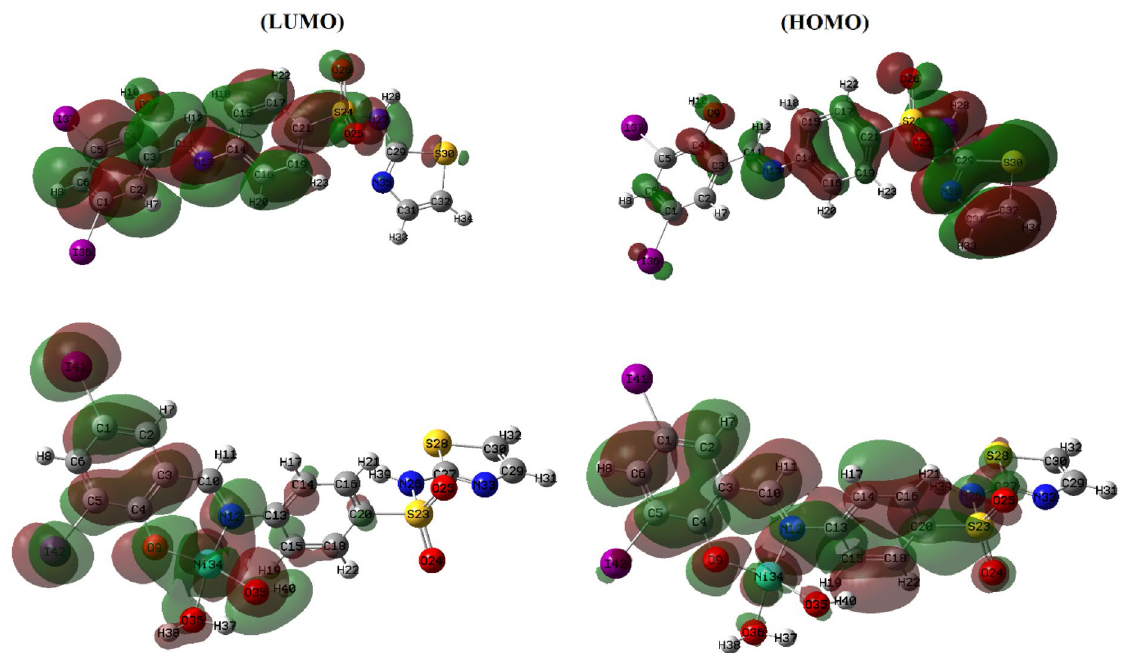
Figure 13. LUMO and HOMO of SB 5 and [Ni(SB 5 –H)(OH)(H 2 O)] complex, using GAUSSIAN 09 software version 9.5 and GAUSSVIEW